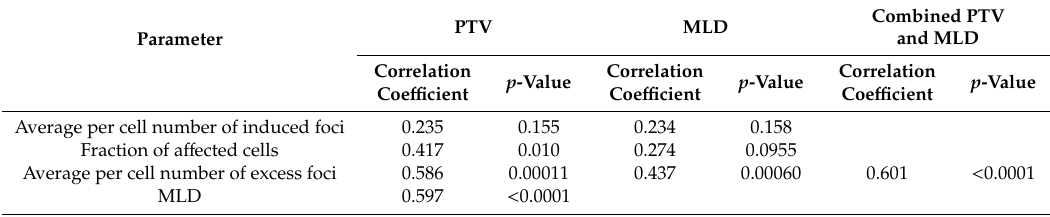
Table 2. Pearson correlation of foci induction at 1 h post first radiotherapy (RT) with planned treatment volume (PTV) and mean lung dose